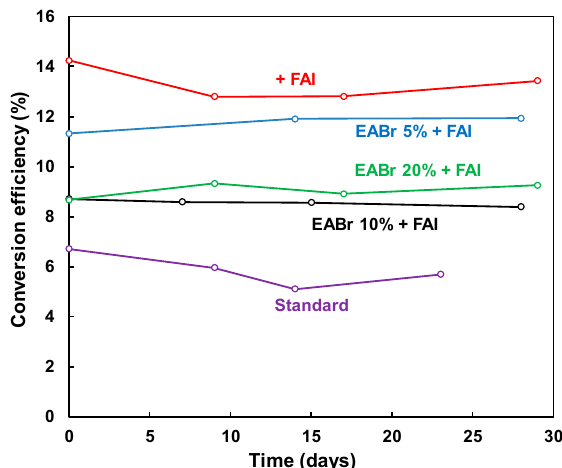
Figure 4. Stability measurements of the fabricated perovskite devices.